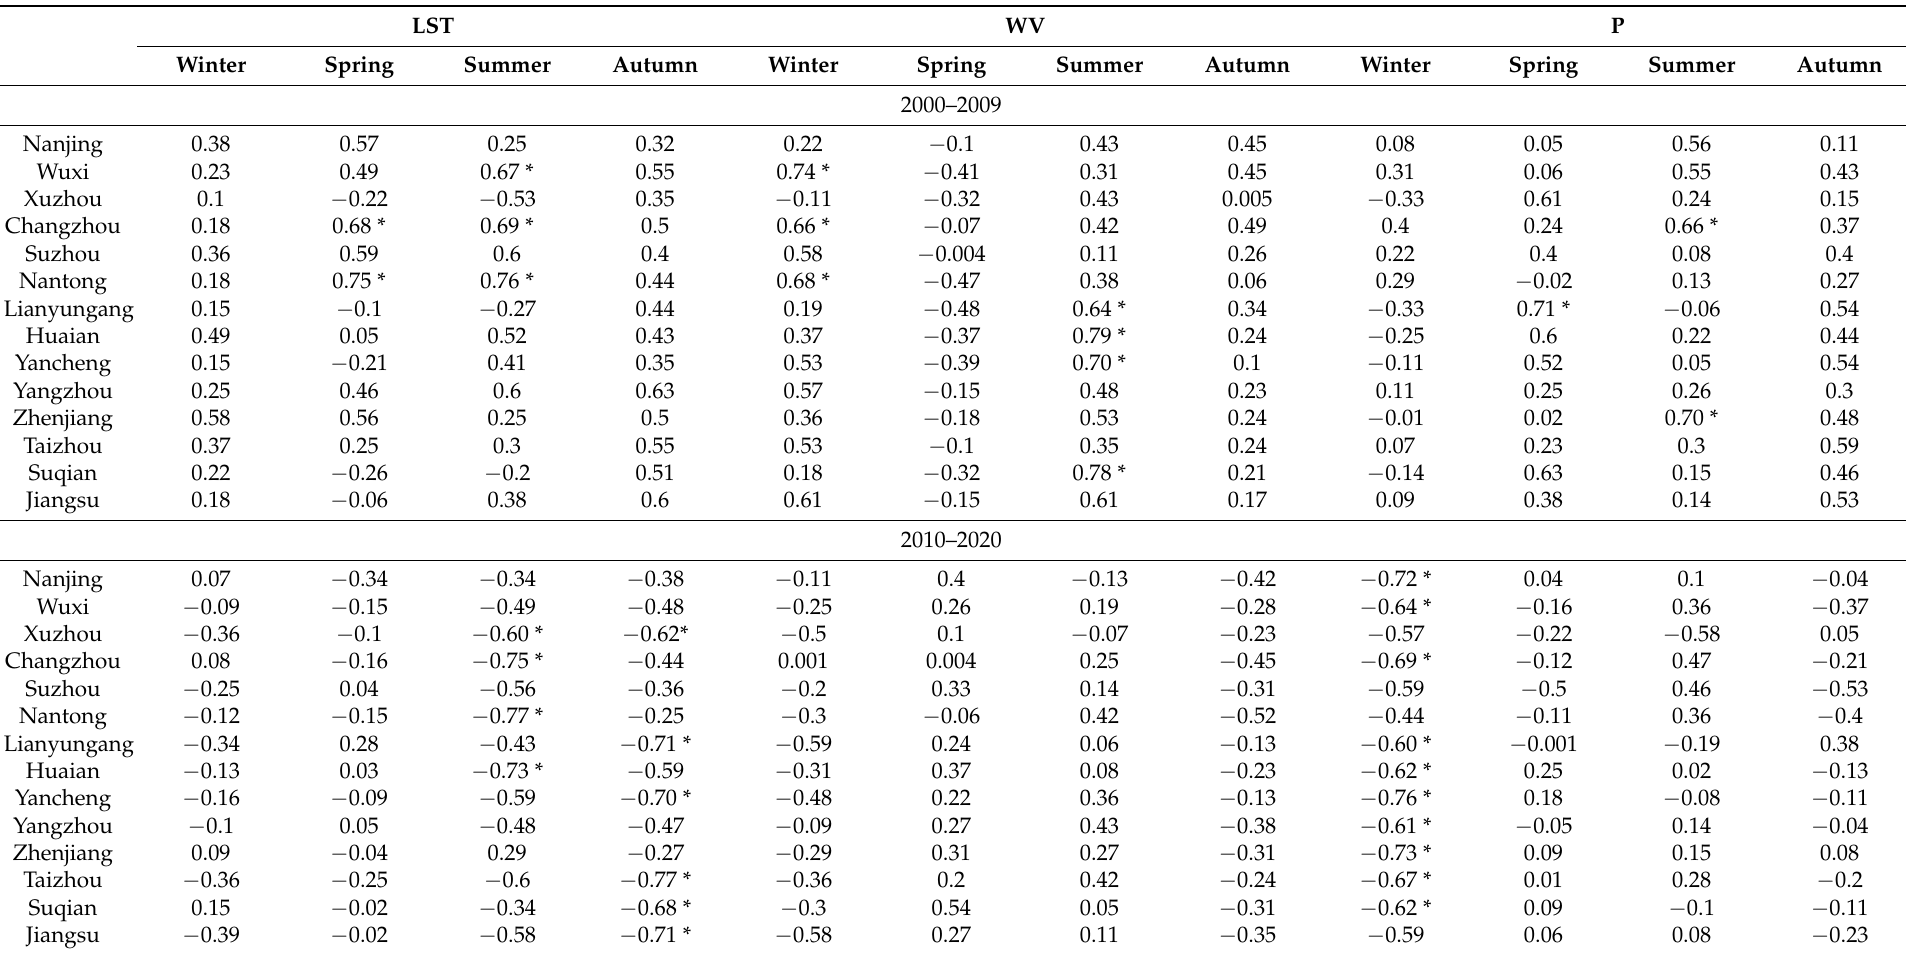
Table 3. Correlation between AOD and meteorological parameters (LST, WV, and P) over the 13 cities of Jiangsu Province. The symbol asterisk (*) represents change at a 95% significance